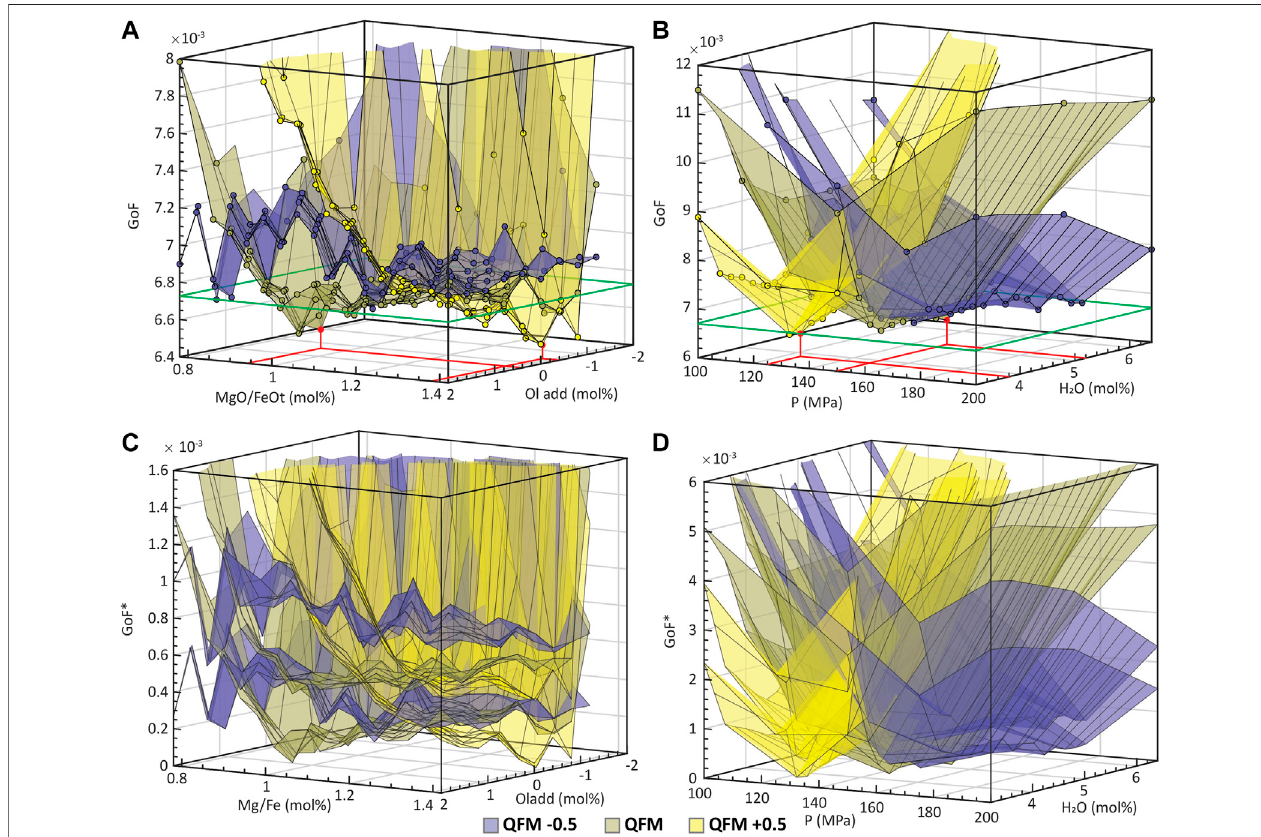
FIGURE 8 | (A) and (B) show the convergence behavior of the GoF parameter with respect to the initial parameters of the MushPEC run for the AK MI set. Each colored surface represents the minimum GoF values for a fi xed f O buffer expressed as Δ QFM from -0.5 to +0.5. The red lines indicate the minimum GoF values for the 2 QFMand QFM +0.5surfaces. Thegreenlinearound theplotsindicates the1 σ limitestimated from theresultsin (C) and (D) . (C) and (D) plotthesurfacesde fi ningthe1 σ con fi dence interval for